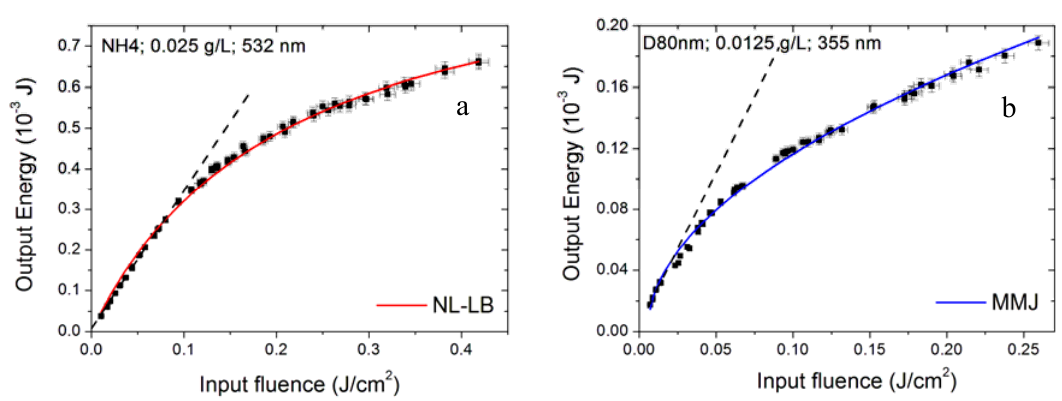
Figure 16. Examples of optical limiting data whose modelling can be univocally identified. The linearity regime is also depicted for reference (dashed black line) ( a ) NL ‐ LB model; ( b ) MMJ model.